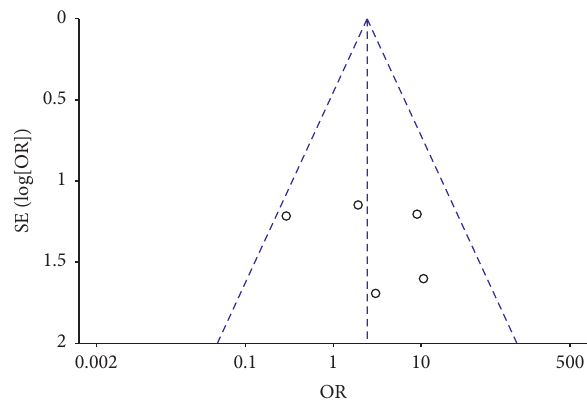
Figure 10: A funnel plot of retinal reattachment rate showing no significant publication bias. SE � standard error, OR � odds ratio.